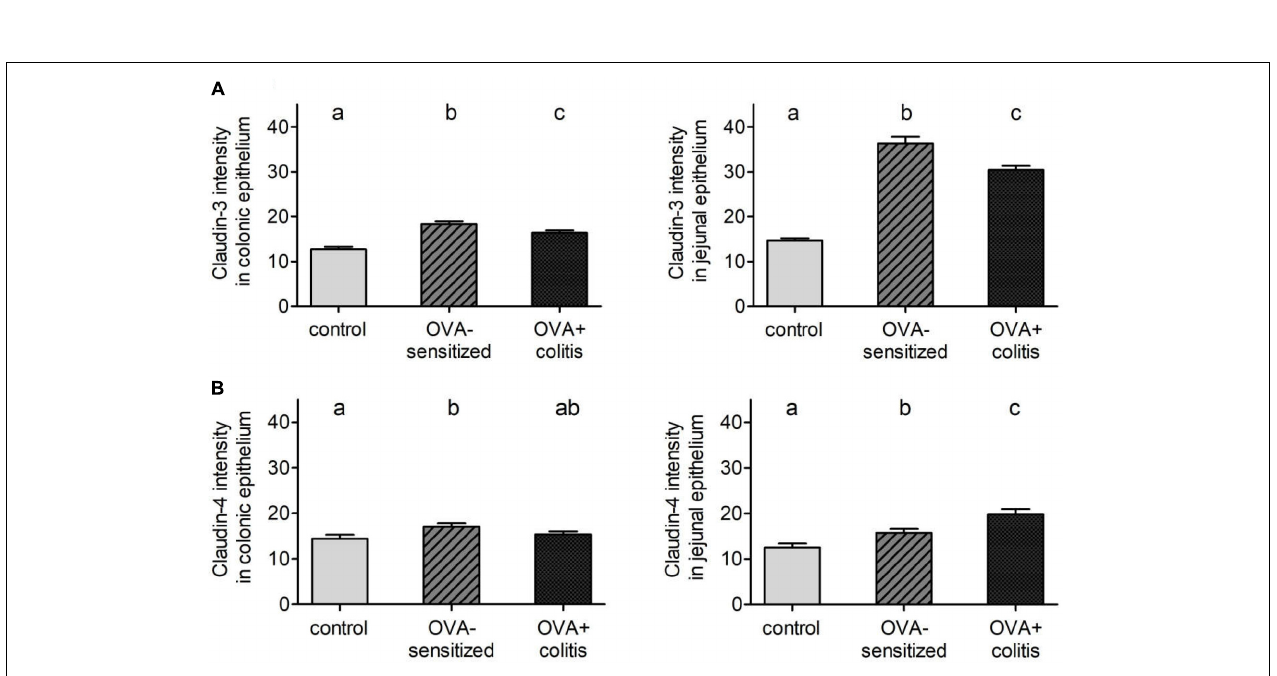
FIGURE 7 | Morphometric analysis of claudin-3 (A) and -4 (B) levels under control conditions (gray bars), in OVA-sensitized animals (crossed bars), and in OVA+colitis (black bars) in distal colon (left) and jejunum (right). Data expressed as mean (bars) + SEM (lines), n = 163–401 cells in each group were counted. Statistically homogeneous groups are labeled with the same letter (a, b, c), thus all groups which do not share the same letter are significantly ( P < 0.05) different from each other (ANOVA followed by LSD post hoc test).